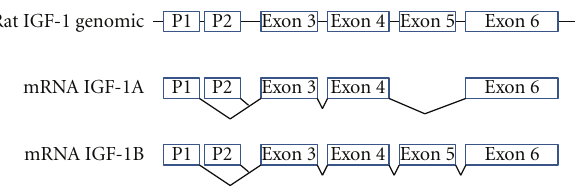
Figure 1: Genomic and mRNA variants of the rat IGF-1 gene . Exons are shown as boxes and introns as lines. IGF-1A lacks exon 5, while IGF-1B contains exon 5. Transcription of IGF-1A and IGF- 1B may begin from within either of promoter 1 (P1) or promoter 2